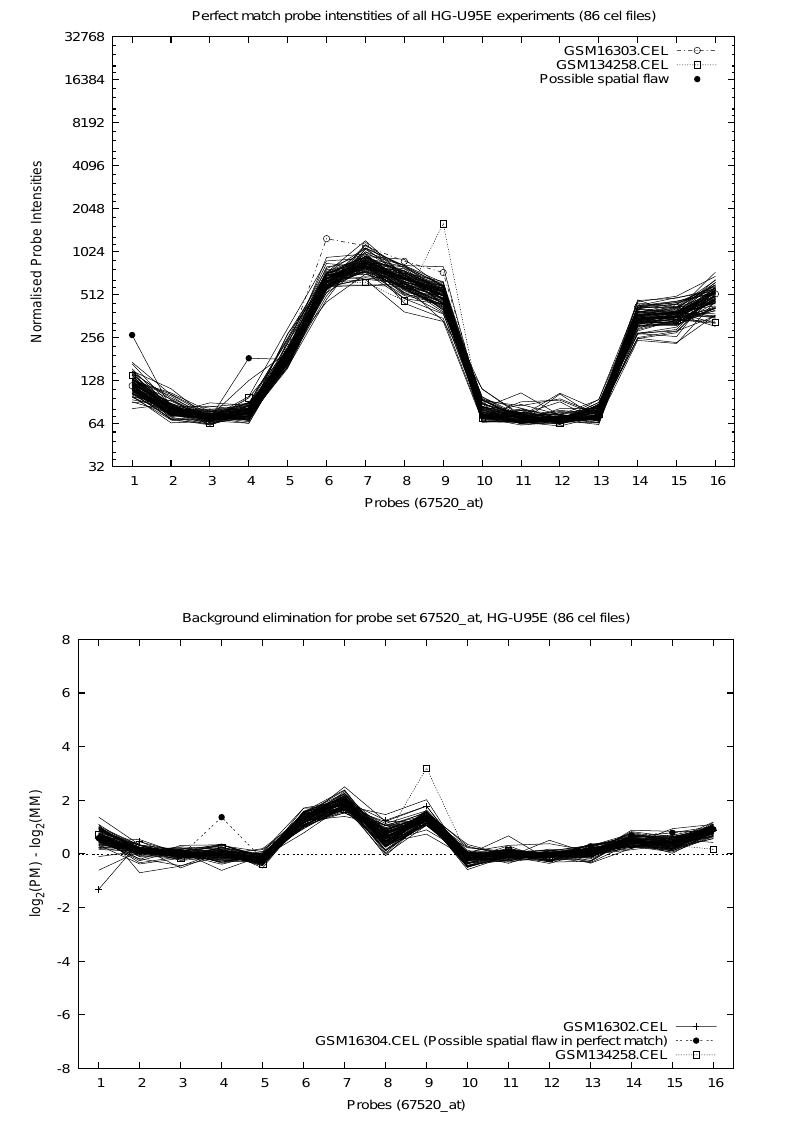
Figure 1: Probe intensities over all cel files for probe set 67520 at on the HG U95E array (A) Perfect match intensities (log scale) (B) Background elimination (log 2 (PM) - log 2 (MM))